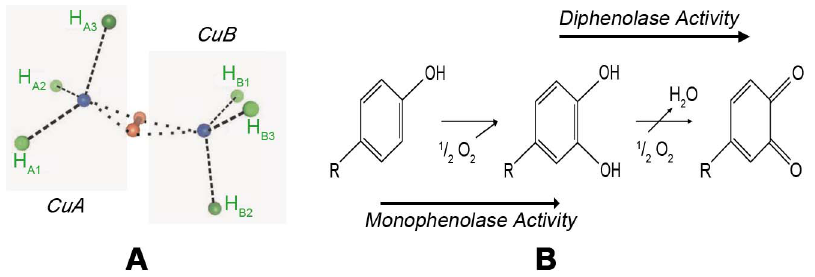
Figure 1. Structure and catalysis of PPOs and related enzymes. A Type-3 copper center. Conserved histidines of the two copper centers (CuA and CuB) are labeled (H A1 -H A3 , H B1 -H B3 ) and colored in green. Copper is colored blue and the oxygen molecules of the bound peroxide in red ( modified from [31]). Phenoloxidase activities. Tyrosinases oxidase monophenolic compounds via their monophenolase activity to diphenols and further to the respective quinones. PPOs mostly just catalyze the conversion of diphenols to quinones (diphenolase activity).